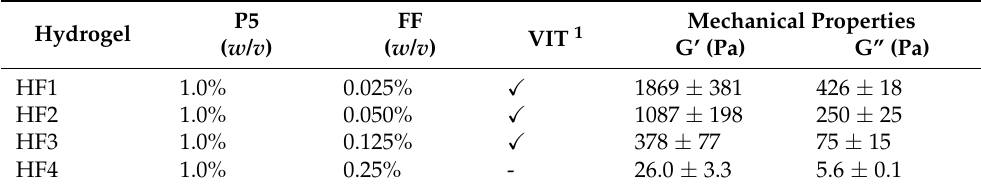
Table 2. Composition and mechanical properties of hydrogels composed of P5 and FF nanotubes.